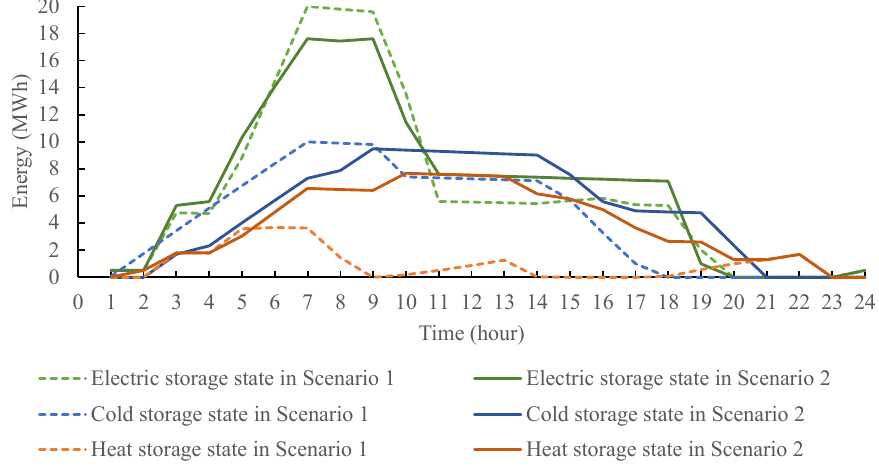
Figure 9. Operation of energy storage equipment.